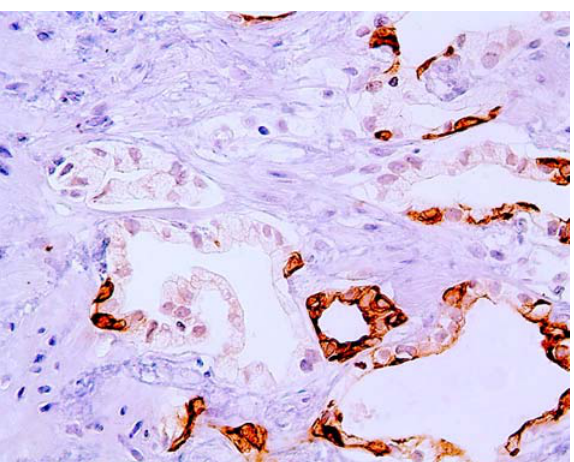
Figure 3 – Partial atrophy (immunohistochemistry: